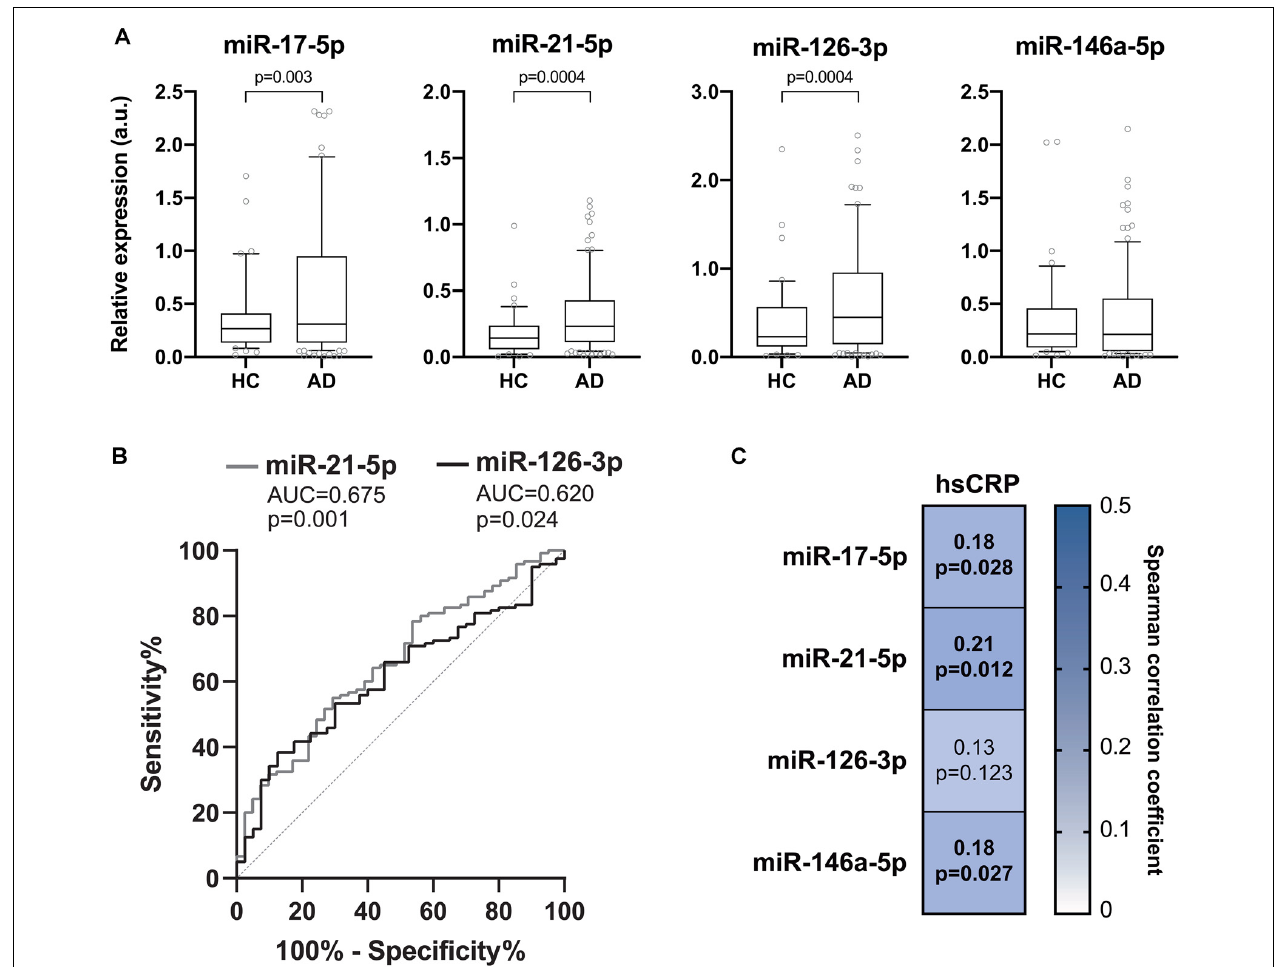
FIGURE 1 | Inflamma-miR levels in healthy and Alzheimer’s disease (AD) subjects. (A) Boxplots showing the plasma miR-17-5p, miR-21-5p, miR-126-3p and miR-146a-5p levels in healthy control (HC, n = 40) and in Alzheimer’s disease (AD, n = 116) subjects. Data are presented as arbitrary units (a.u.) of selected miRNA relative expression (RE) normalized with cel-miR-39. P -values for Mann-Whitney U tests. (B) Receiver-operating characteristic (ROC) curves of miR-21-5p and miR-126-3p RE (a.u.) for the diagnosis of AD. The area under the curves (AUCs) and corresponding p -values are reported. (C) Correlation plot showing Spearman’s correlations between circulating levels of inflamma-miRs and serum hsCRP. Spearman’s rho coefficients and p- values are reported. The background color depends on the magnitude of the correlation. Significant correlations are marked in